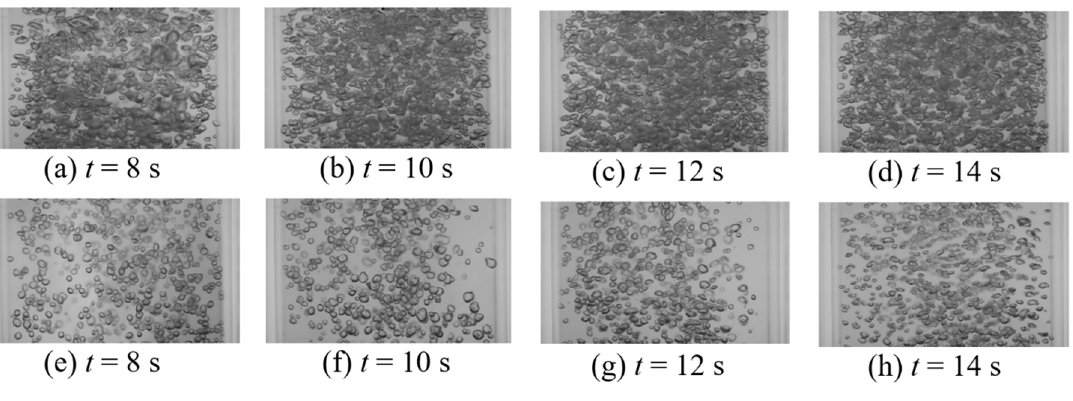
Figure 11. Instantaneous images of mixing of the dye in ( a – d ) static (experiment #5 from Table 1) and ( e – h ) vibrating (vibrating experiment #4 from Table 2) bubble column.